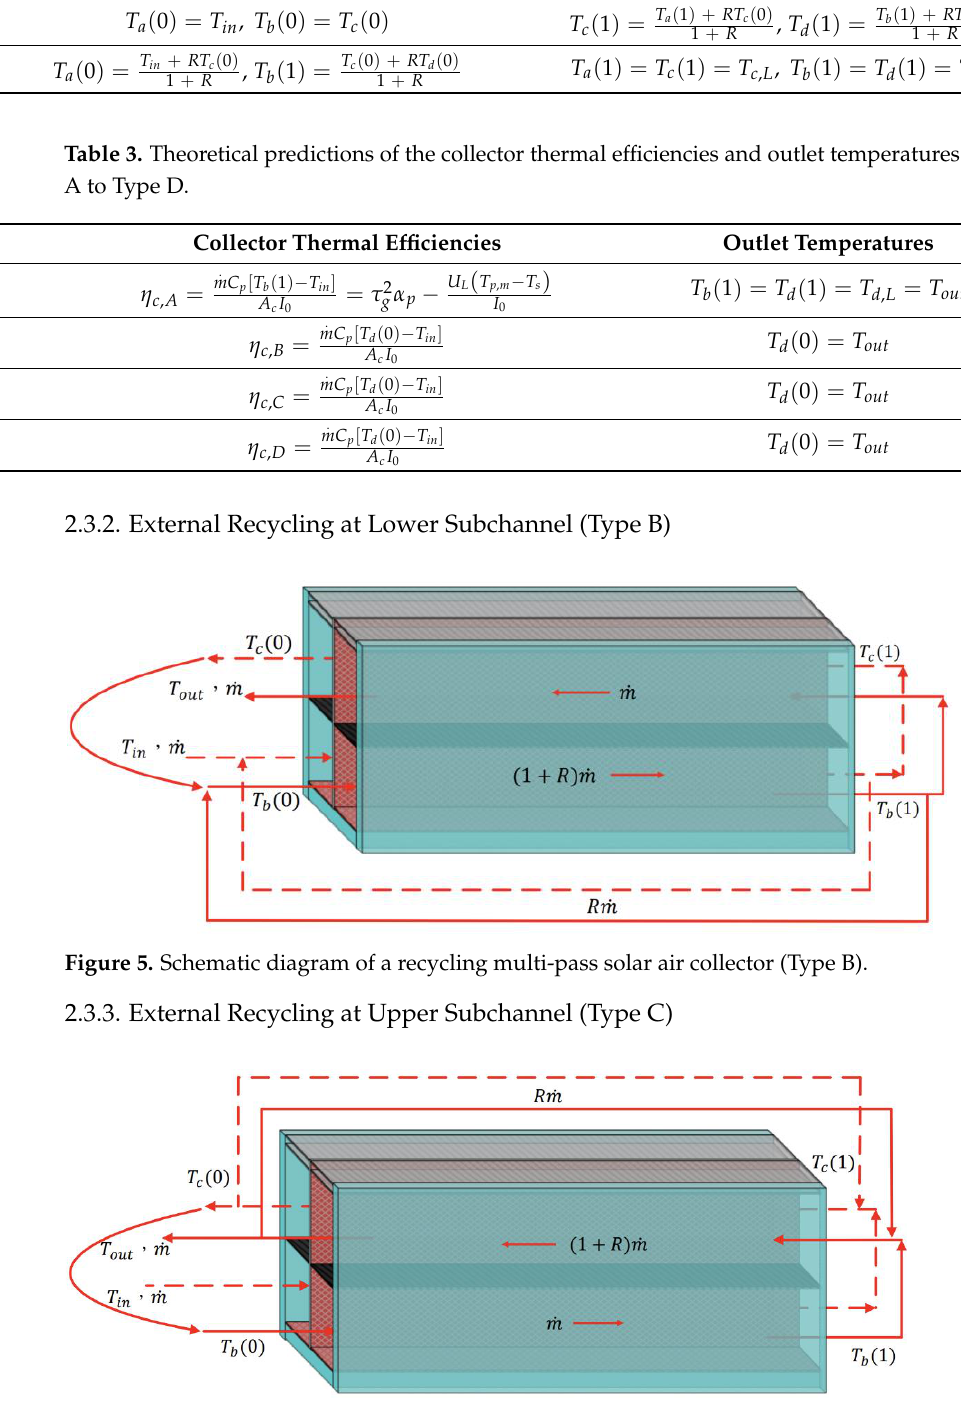
Figure 7. Schematic diagram of a recycling multi-pass solar air collector (Type D). 2.4 Hydraulic Dissipated Power The friction loss in each subchannel may be estimated by ℓ𝑤 𝑓 = 2𝑓 𝐹 𝑣̅ 2 𝐿 𝐷𝑒 𝑖 , 𝑖 = 𝑎, 𝑏, 𝑐, 𝑑